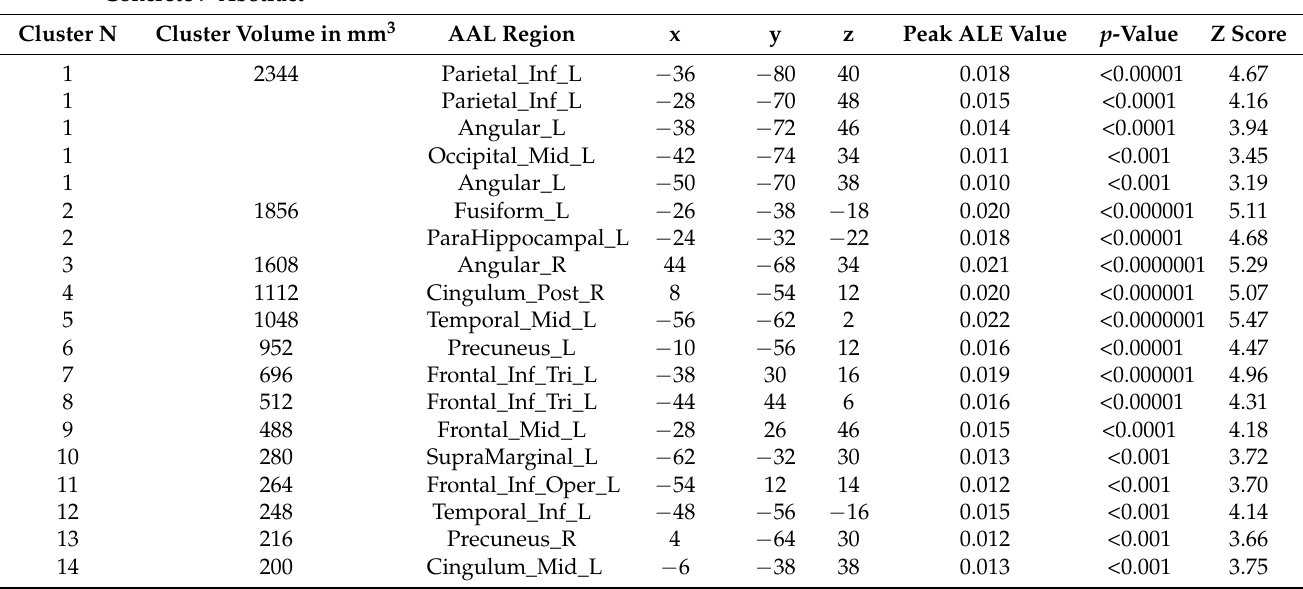
Table 3. Results for the concrete > abstract comparison. Results are reported in Montreal Neurological Institute (MNI) space with anatomical labels from the Automated Anatomical Atlas (AAL). L = left; R = right.